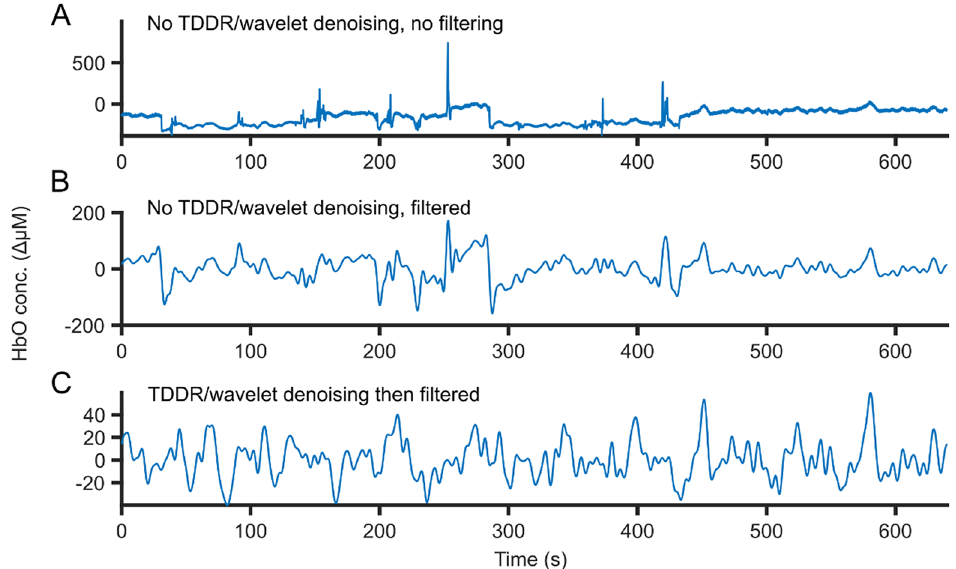
Figure 4. An example of TDDR and wavelet denoiser’s effect on the data. ( A ) The raw data processed with only optic density and modified beer-lambert law conversion, demonstrating spike-like artefacts from movements. ( B ) The data processed with only optical density, modified beer-lambert law and a bandpass filter (0.01 to 0.25 Hz), with the spikes still present and smoothed out from the filtering. ( C ) Data cleaned first by TDDR and wavelet denoising before standard processing as in ( A ), with visible reduction in artefacts.